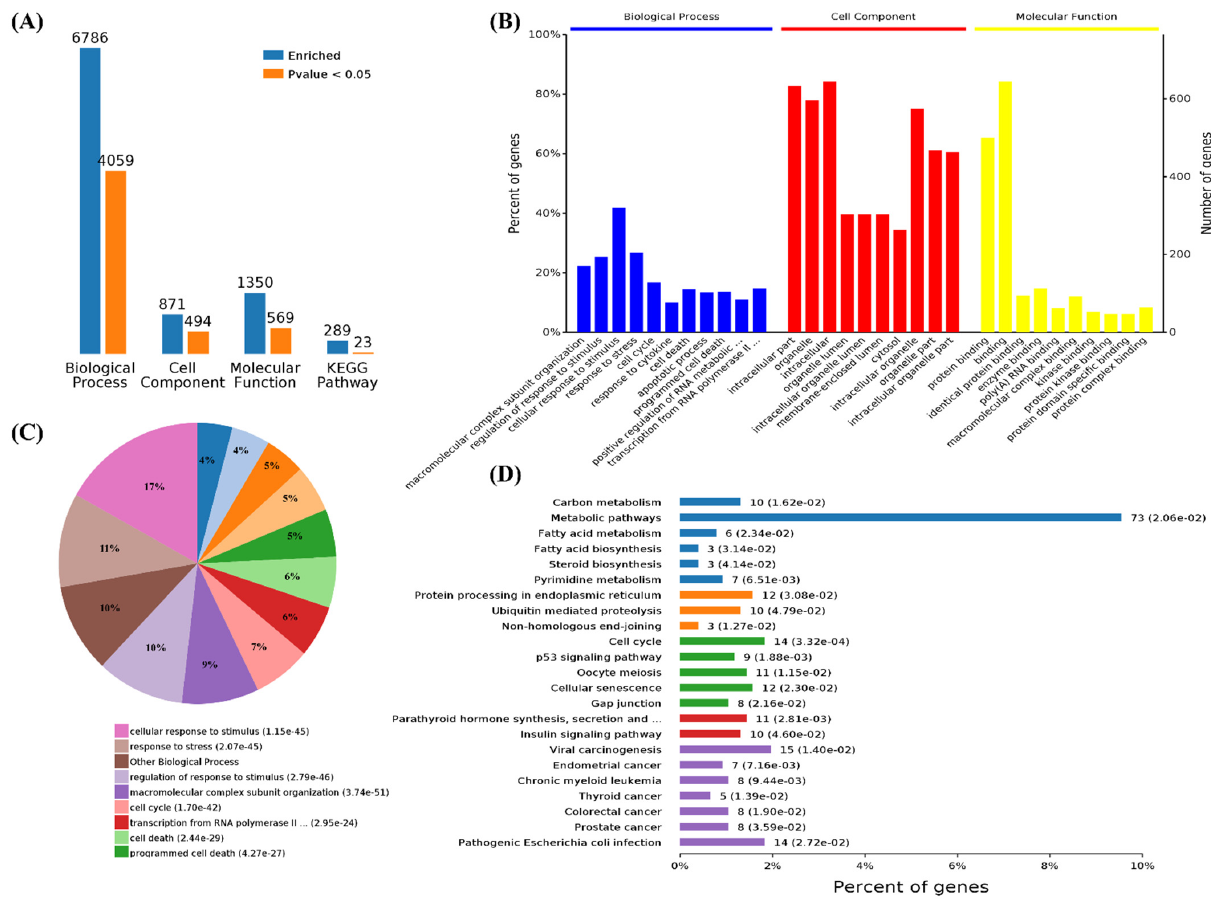
Figure 4. Functional enrichment and KEGG pathway analysis of SARS-CoV-2 alone induced upreg- ulated genes. ( A ) Number of upregulated genes enriched in GO terms and KEGG pathways, blue represents all enriched GO terms, and orange represents significantly enriched GO terms, p < 0.05. ( B ) Overview of significantly enriched biological process (in blue), cell component (in red), and mo- lecular function (in yellow) of the upregulated genes induced by SARS-CoV-2 infection. ( C ) Pie chart of an enriched biological process of the upregulated genes. ( D ) Percentage of genes related to en- riched KEGG pathways.